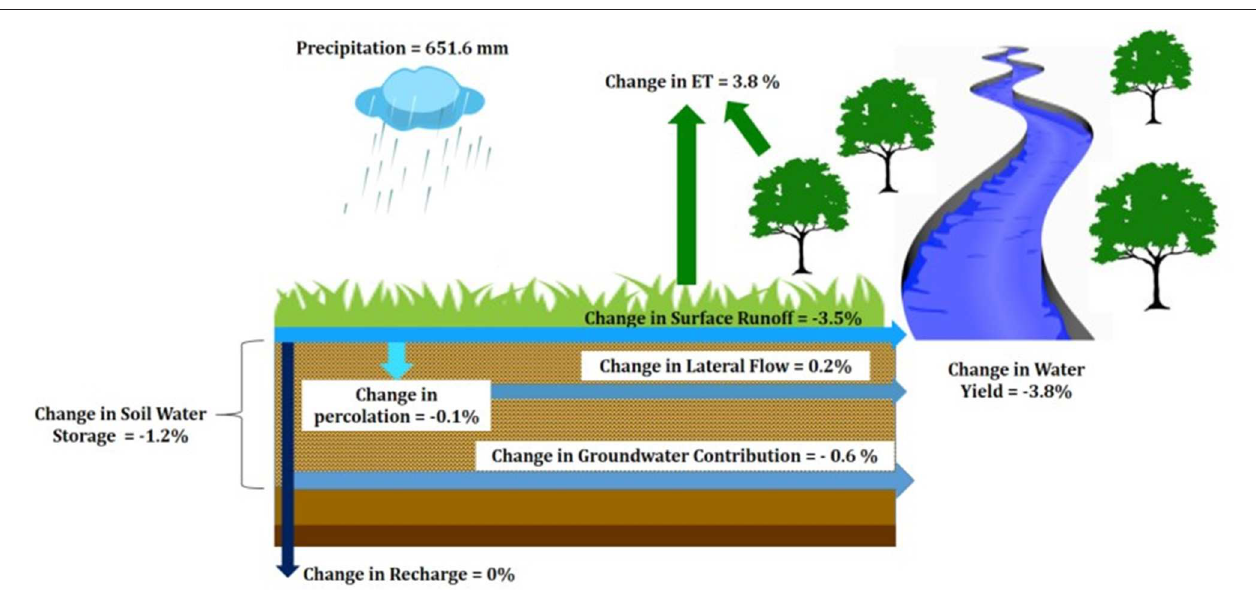
FIGURE 3 | Differences in average annual total water balance components over the simulation period (2003–2009). The primary impact is a shift from surface runoff to ET, which also decreases water yield. Soil and groundwater are generally unaffected or experienced slightly negative impacts relative to the direction hoped for by impact